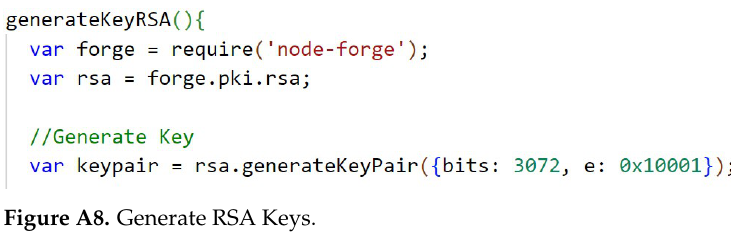
Figure A8. Generate RSA Keys.